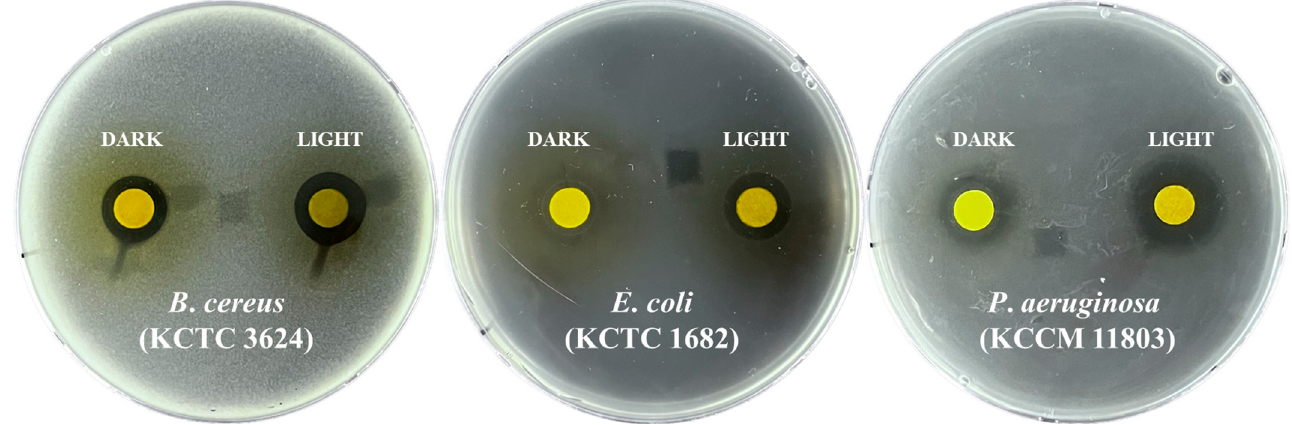
Figure 2. Representative images showing antibacterial activities of methanol extracts of P . frutescens microgreens for 20 days of long-day photoperiod and continuous darkness conditions. 3. Discussion Plant microgreens are commonly produced using di ff erent photoperiods or sequen- tial darkness. These growth conditions can cause di ff erences in phenotype, growth, de- velopment, and metabolism because light is necessary for plant photosynthesis [21]. In this study, P . frutescens microgreens were successfully grown under light treatment (16 h/8 h light-dark) and continuous treatment for 10, 15, 20, and 25 days. P . frutescens micro- greens grown in darkness possessed yellow cotyledons, and the microgreens grown in the light treatment had green cotyledons. This may have been due to the accumulation of chlorophyll and carotenoids. Previously, chlorophyll and carotenoid biosynthetic genes were upregulated when the plant seedlings were exposed to light [22], and lower levels of carotenoids and chlorophylls were con fi rmed in radish, soybean, mung bean, and pumpkin spouts compared with light treatment [23]. Despite these phenotypic di ff er- ences, the growth pa tt erns (dry weight) of the microgreens grown under both conditions were not signi fi cantly di ff erent. Furthermore, the accumulation pa tt erns of phenolics (ros- marinic acid and total phenolic content) in P . frutescens microgreens were not signi fi cantly di ff erent during the long photoperiod. However, the production pa tt erns of phenolics gradually increased and then decreased during sequential darkness. Twenty days of cul- tivation in the dark resulted in the highest production of rosmarinic acid and total phe- nolic content. Previous studies have reported that variations in the production of phenolic compounds in plant microgreens may be due to di ff erent plant species, germination stages, light sources, and photoperiods. For example, Mastropasqua et al. (2020) reported that the production of total phenolic content was not signi fi cantly di ff erent in radish, soy- bean, mung bean, and pumpkin spouts grown under a long photoperiod or in continuous darkness [23]. However, Siriparu et al. (2022) reported that total phenolic content in mung